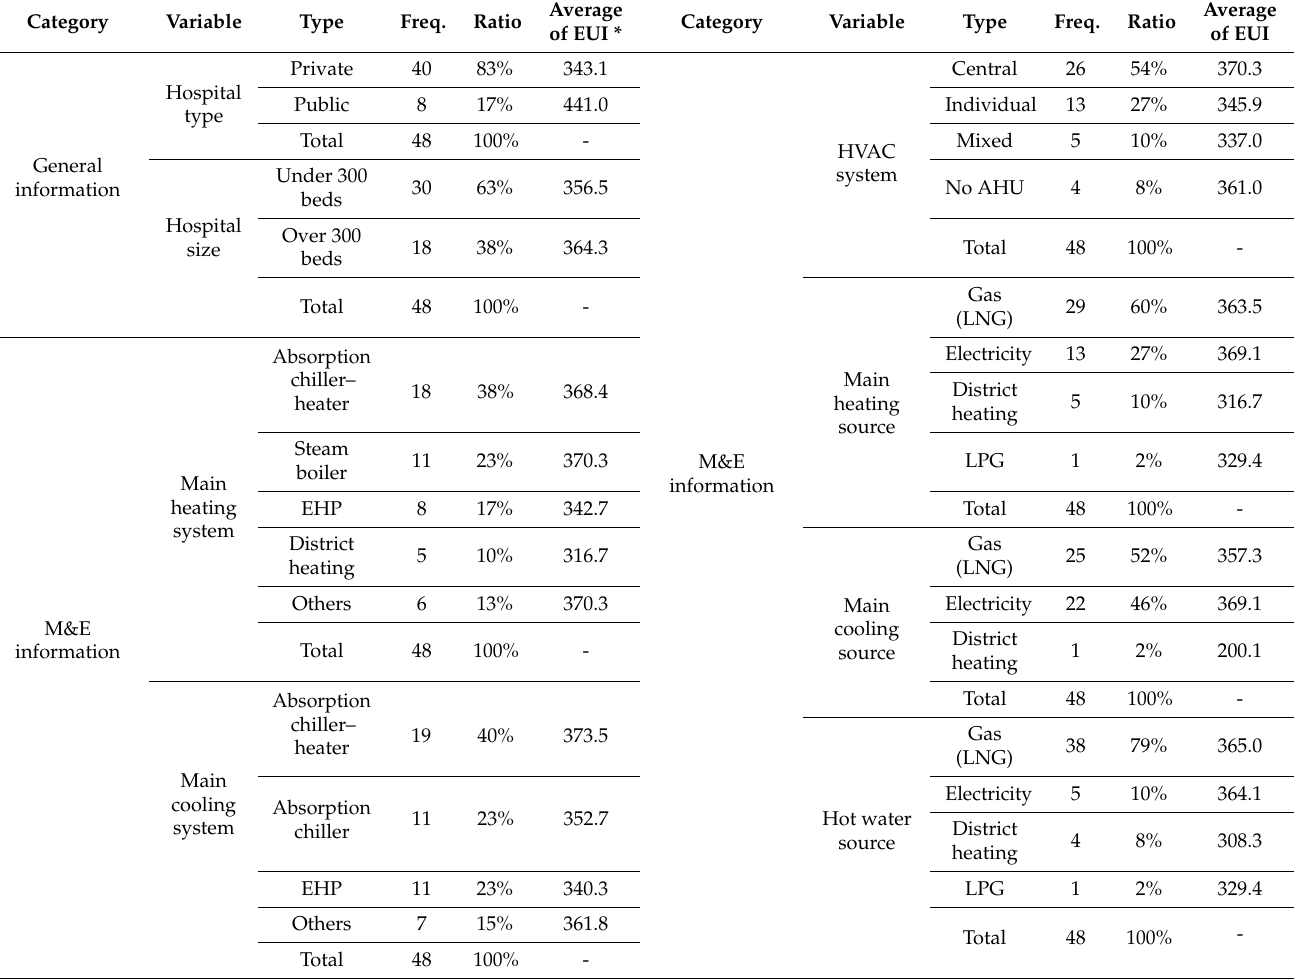
Table 9. Results of the average energy consumption by the characteristics of discrete